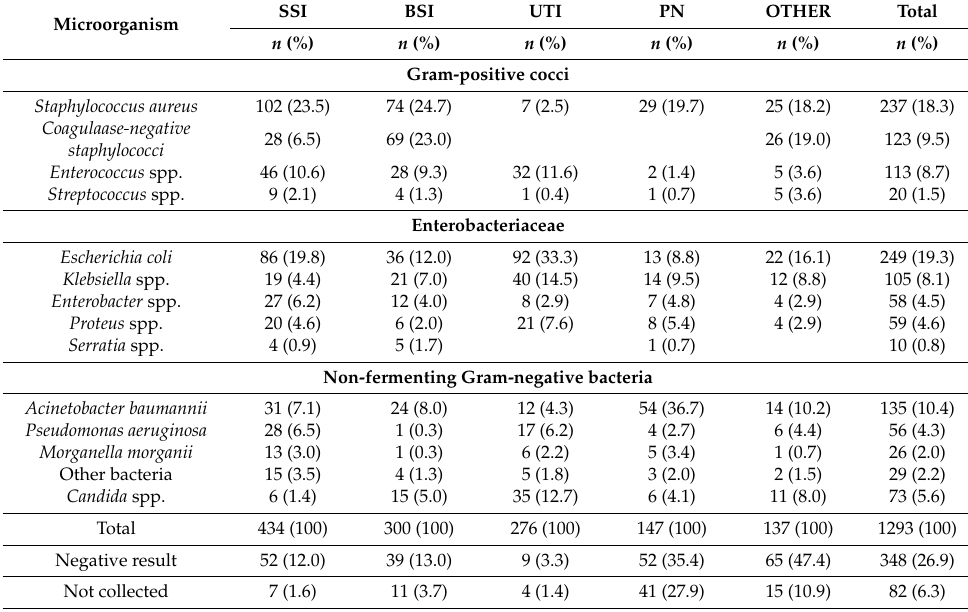
Table 4. Aetiology of different types of healthcare-associated infections (HAIs), without gastrointestinal